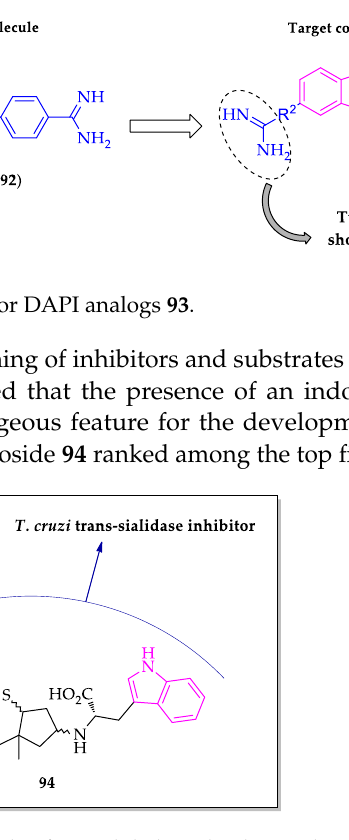
Figure 12. Example of an indole-based galactoside with inhibitory activity of T. cruzi trans-sial- idase.